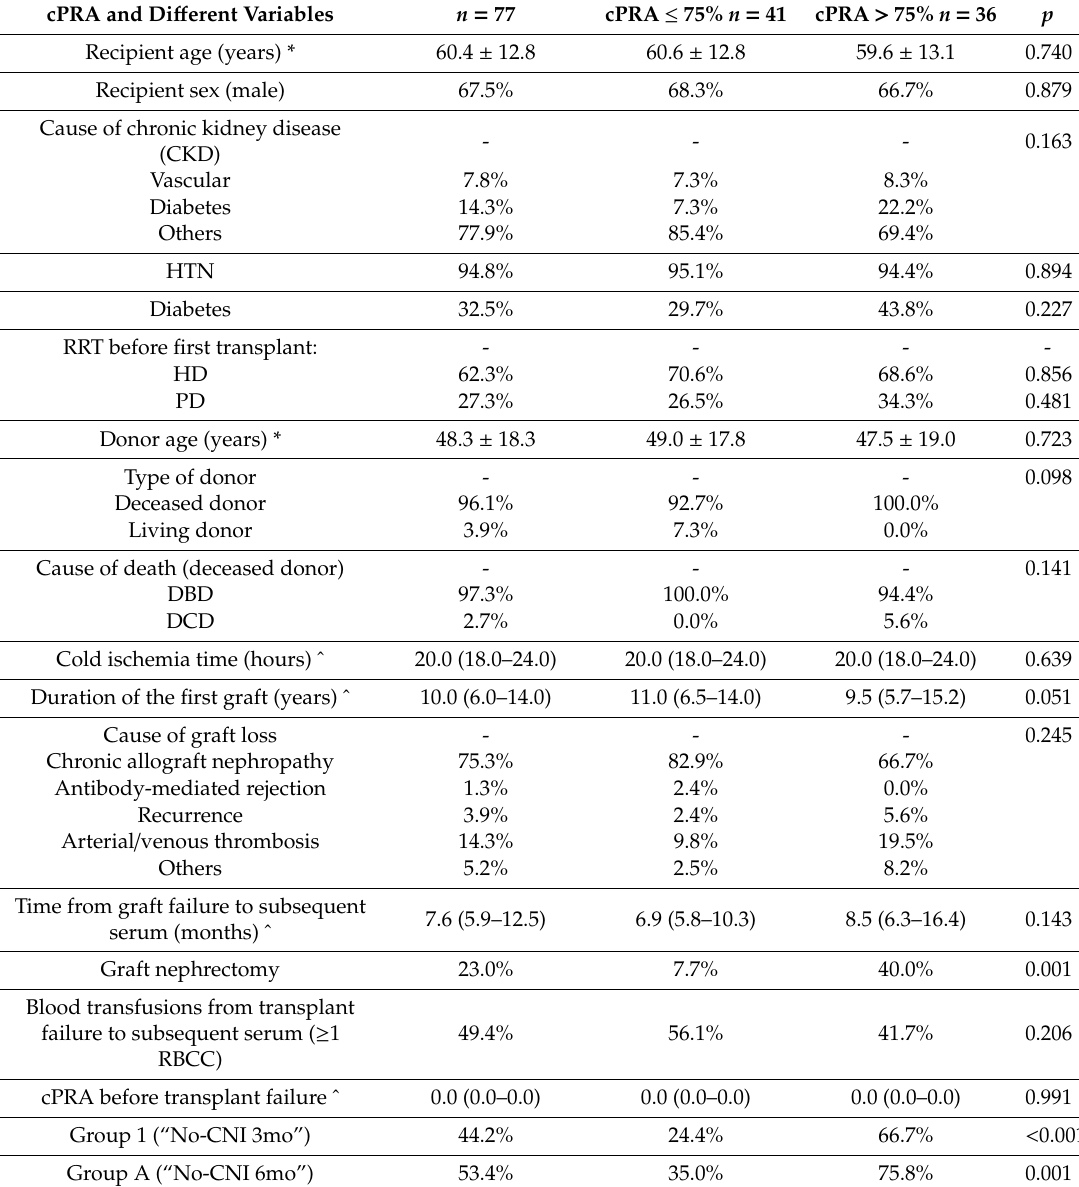
Table 1. Patient characteristics in relation to the development of calculated panel-reactive antibody (cPRA) ≤ or > 75% after transplant failure. Continuous variables were expressed as mean ± SD (*) or median and interquartile range (ˆ) according to their distribution. The bold: p values less than 0.05 defined statistical